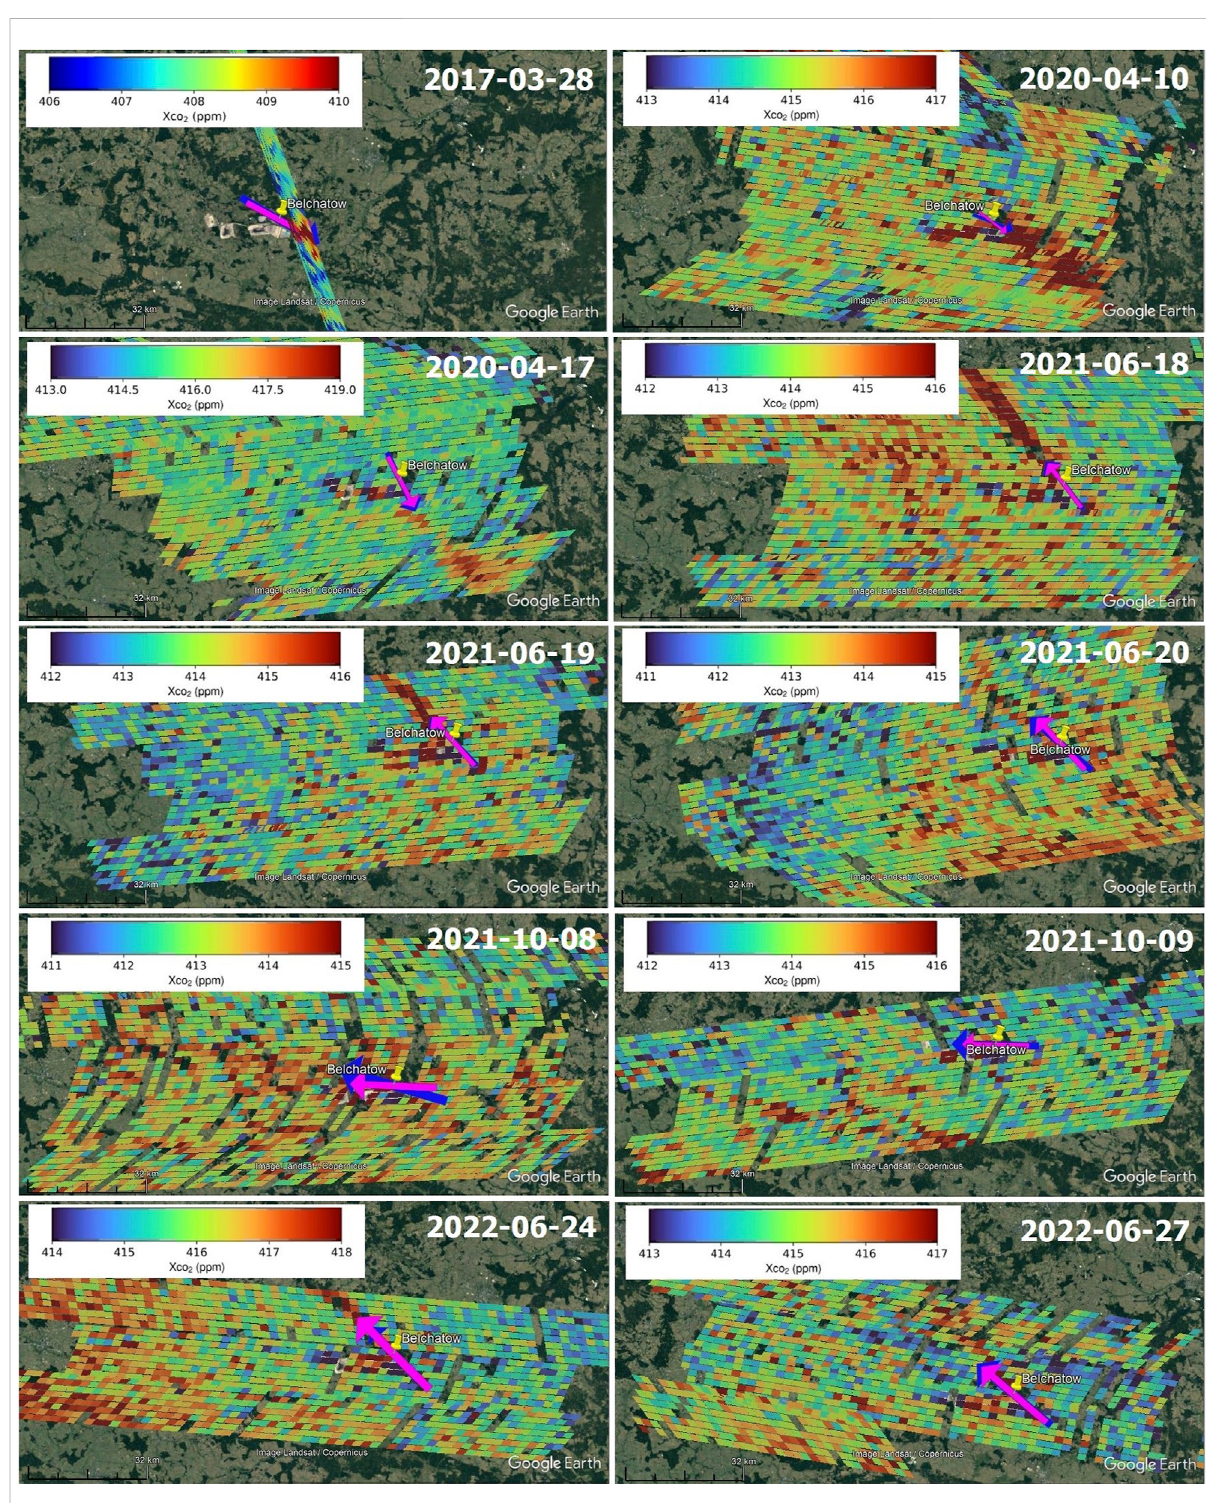
FIGURE 1 Be ł chat ό w Power Plant overpasses from OCO-2 (2017-03-28) and OCO-3 (all others). Colored parallelograms are bias-corrected XCO 2 footprints with customized color scales, overlaid on Google Earth Landsat/Copernicus satellite surface imagery. The power plant location is the yellow tack and the MERRA-2 (blue) and ERA-5 (pink) wind vectors are shown as arrows of length proportional to wind speed. The spatial scale is indicated in the lower left of each